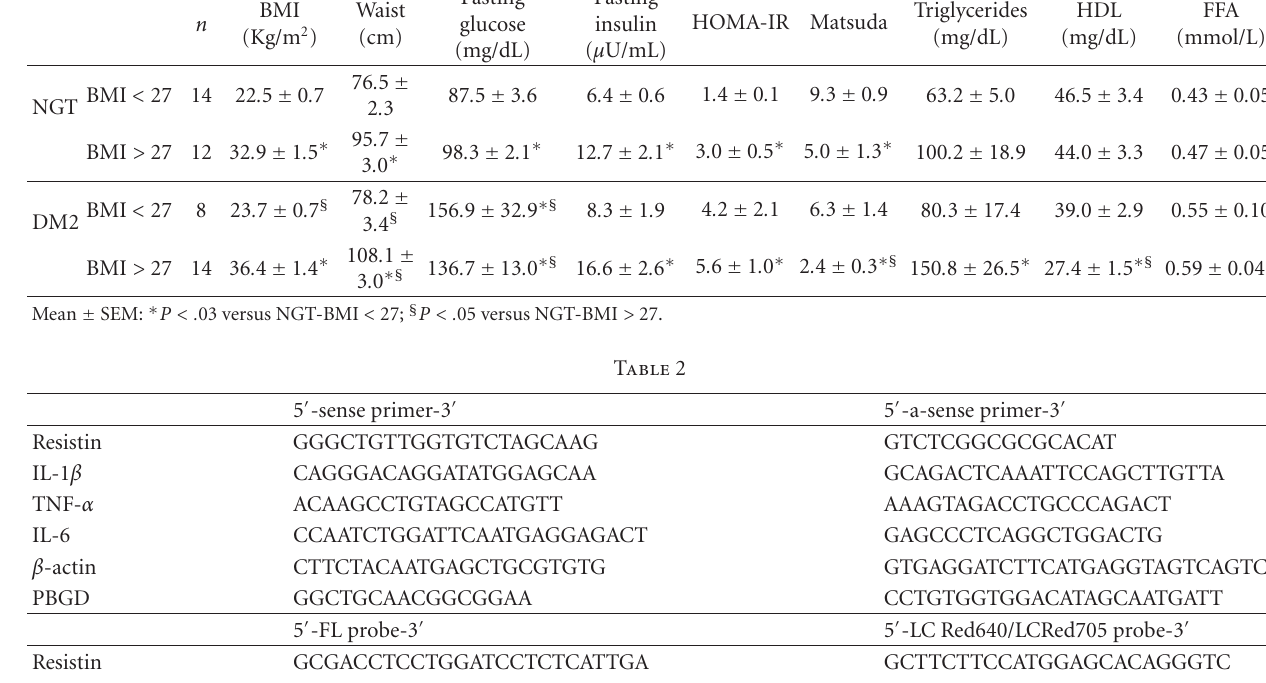
Table 1: Patients’ characteristics, their fasting glucose, fasting insulin, triglycerides, HDL and FFA levels, the HOMA-IR and Matsuda indices. Fasting Fasting Waist BMI HOMA-IR Matsuda glucose insulin n (cm) (Kg/m 2 ) (mg/dL) ( μ U/mL) BMI < 27 14 22 . 5 ± 0 . 7 NGT